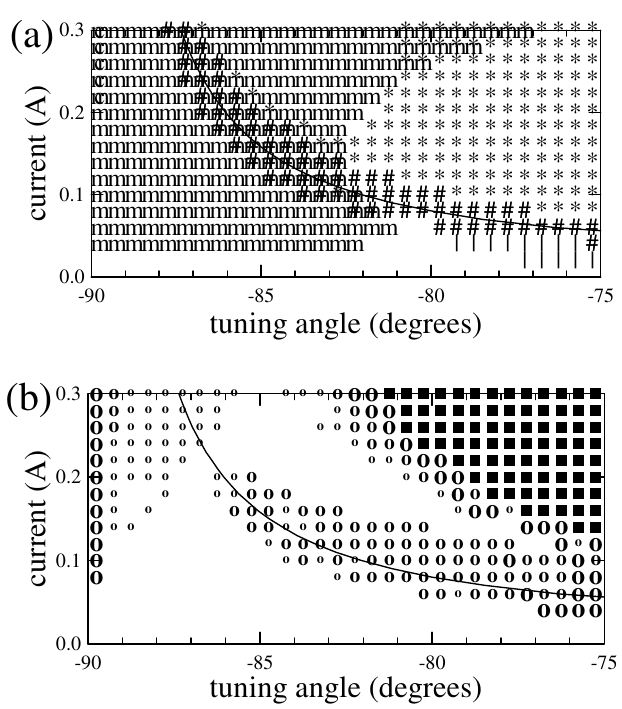
FIG. 8. Modeling for the Aladdin low-emittance lattice with microwave instability from the broadband impedance j Z 3 : 8 (cid:3) . A curve shows the parameters for optimal bunch length- ening. (a) Analytic predictions. m: microwave instability; |: coupled-dipole Robinson instability; *: coupled-quadrupole Robinson instability; #: fast dipole-quadrupole mode-coupling Robinson instability; c: coupled-bunch instability with longitu- dinal mode number of 1. (b) Results of 500 000-turn simulations of 60 000 macroparticles. o: mild instability, where the energy spread exceeds its natural value by (10–30)%; o : moderate instability, where the energy spread has increased by (30– 100)%; O : strong instability, where the energy spread has increased more than 100%; (cid:1) : lost macroparticles.